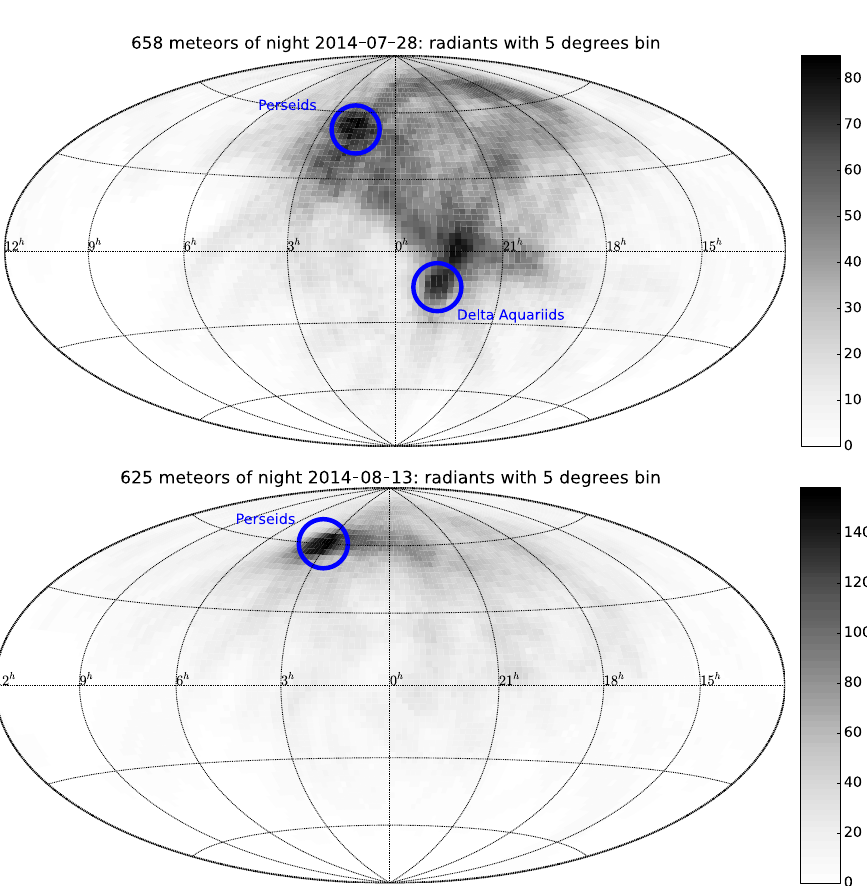
Fig. 6. Observations of meteors in monitoring mode. Top: pair-wise intersections (map of possible radiants) of meteor trails detected on 2014 July 28 (the highest peak in the top panel of Fig. 5). The radiant corresponding to the Delta Aquariids meteor stream is clearly seen, along with the onset of the Perseids meteor stream that peaked two weeks later. Bottom: map of possible radiants of meteor streams detected on 2014 August 13. The radiant corresponding to the Perseids meteor stream is